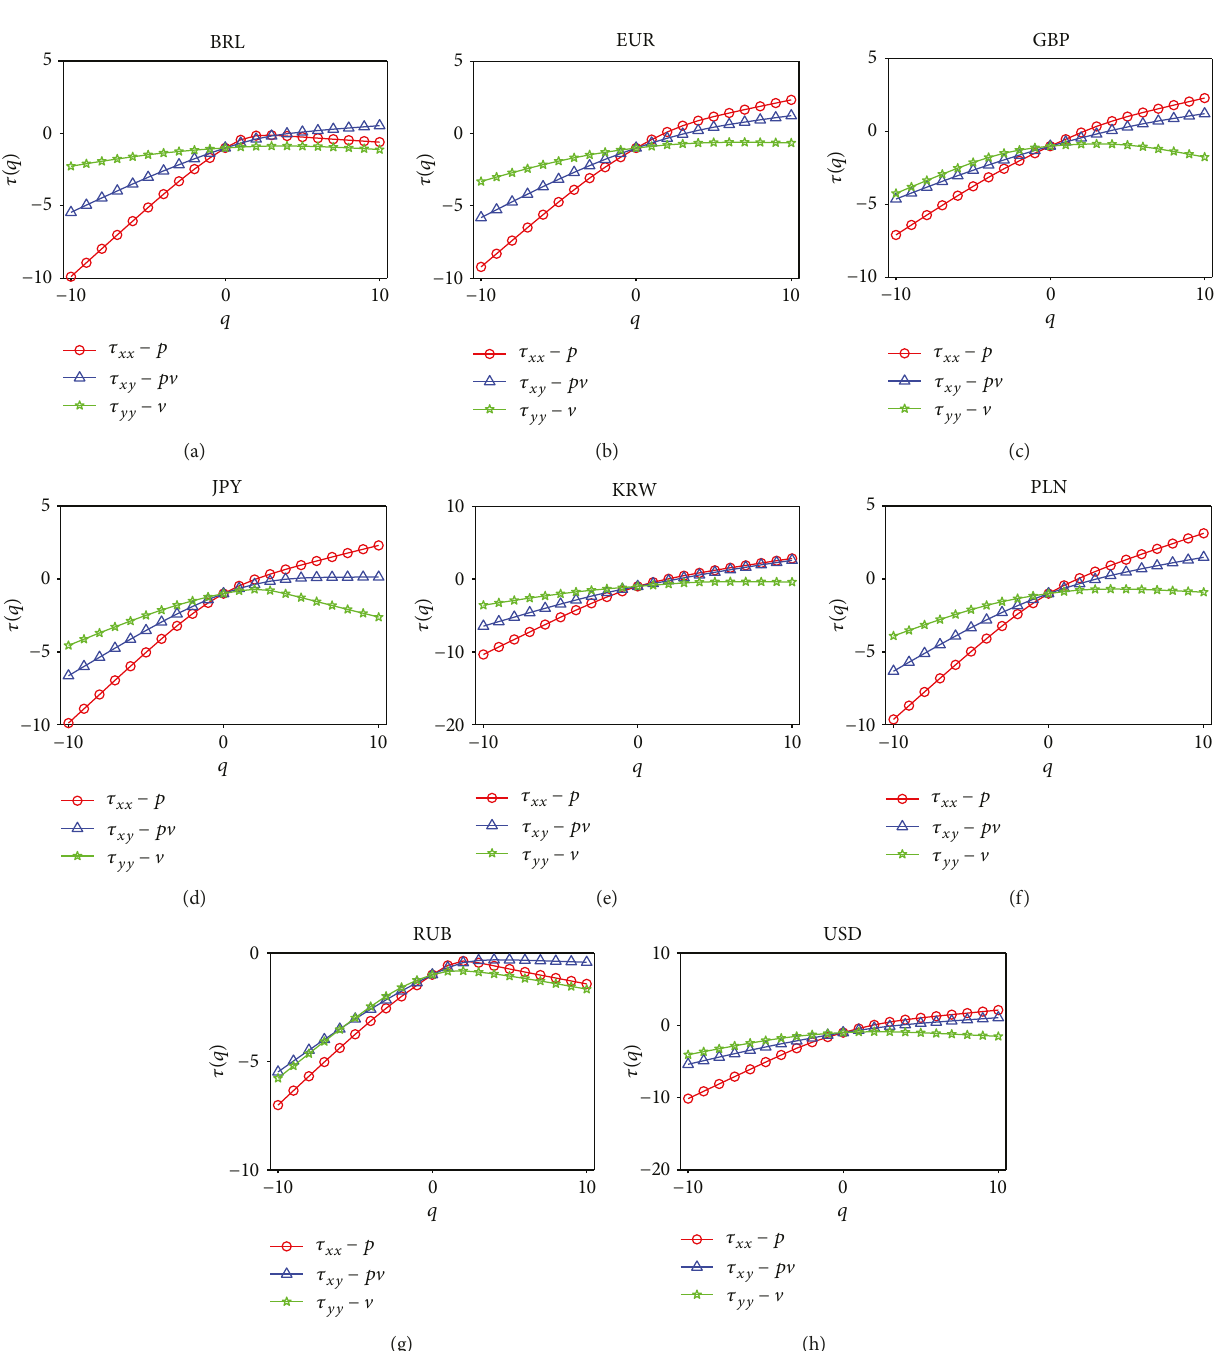
Figure 7: The mass exponent values of τ q for di ff erent q